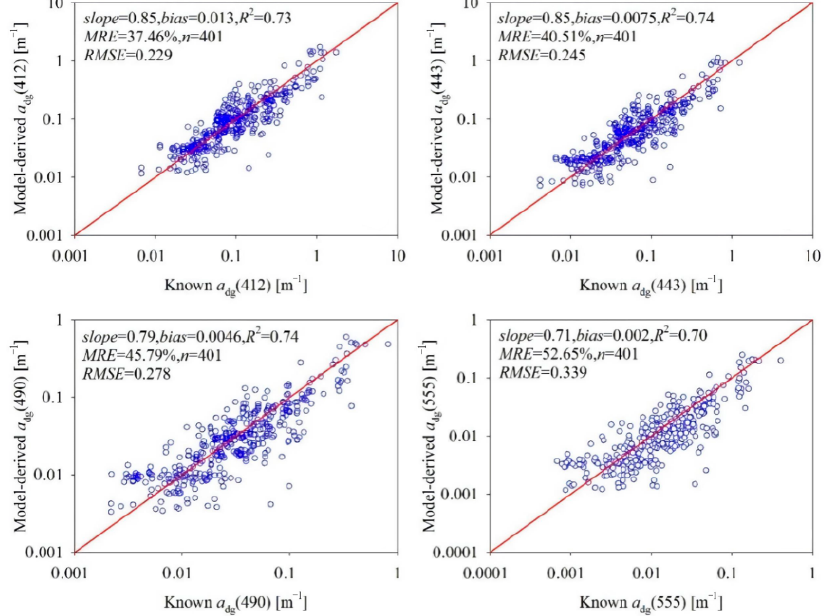
Figure 8. Precision of satellite-derived a dg ( λ ) products using the TAA model. Figure 9 details the accuracies of the a ph ( λ ) products derived from the AA model.